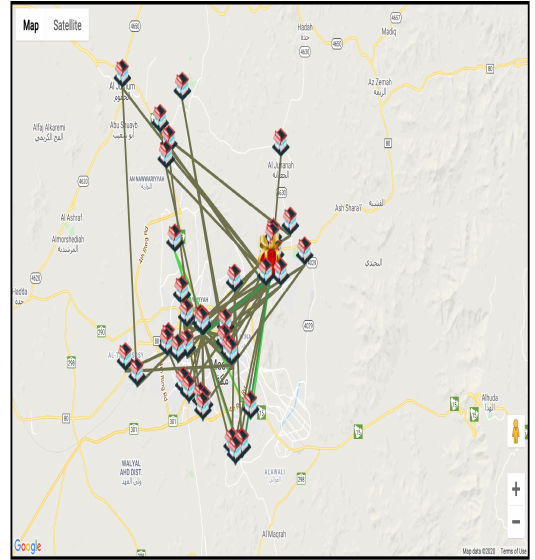
Figure 4. Route plan proposed by the Ekram system before applying